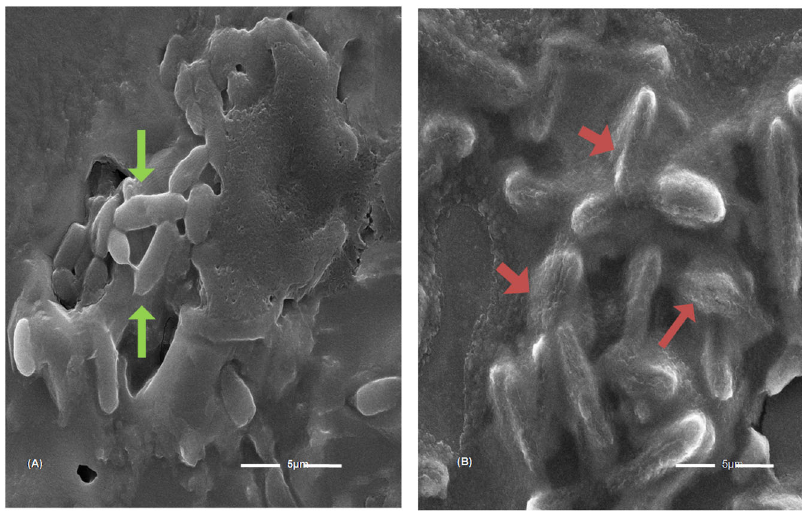
Table 1 Antibacterial activity of CuO/GO nanocomposite Name of the test strain